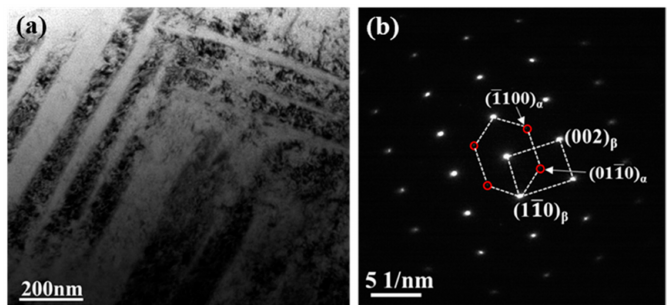
Figure 5. Microstructure of EP0.58 after tensile tests at 77 K: ( a ) Bright field image. ( b ) (110) β zone axis SEAD